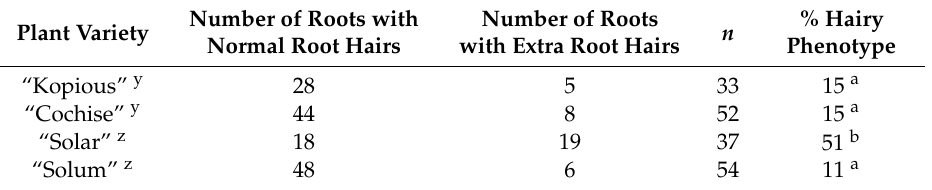
Table 3. Measurement of root hairs in conventional y and drought tolerant z barley varieties. Number of Roots with Number of Roots Plant Number of Roots with Plant Variety Normal Root Hairs with Extra Root Variety Normal Root Hairs